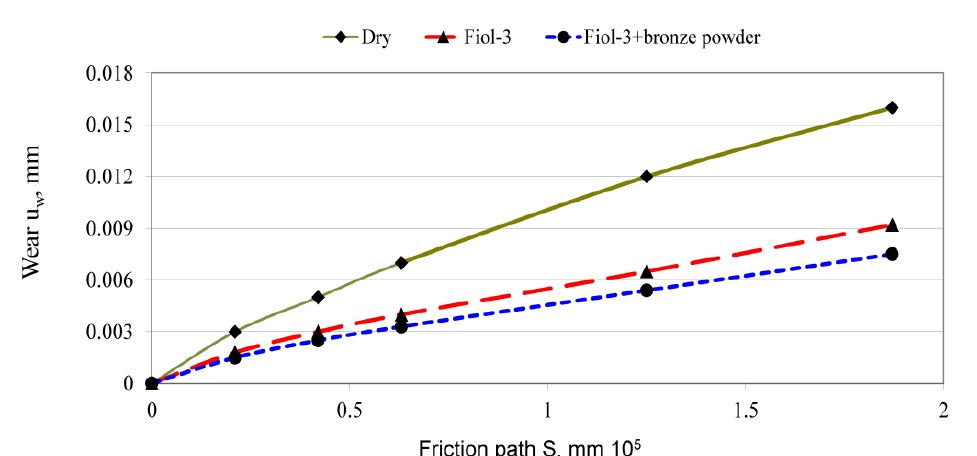
Fig. 5. Dependences of wear on the friction path with free contact of the cylinders ( Q = 100 N)